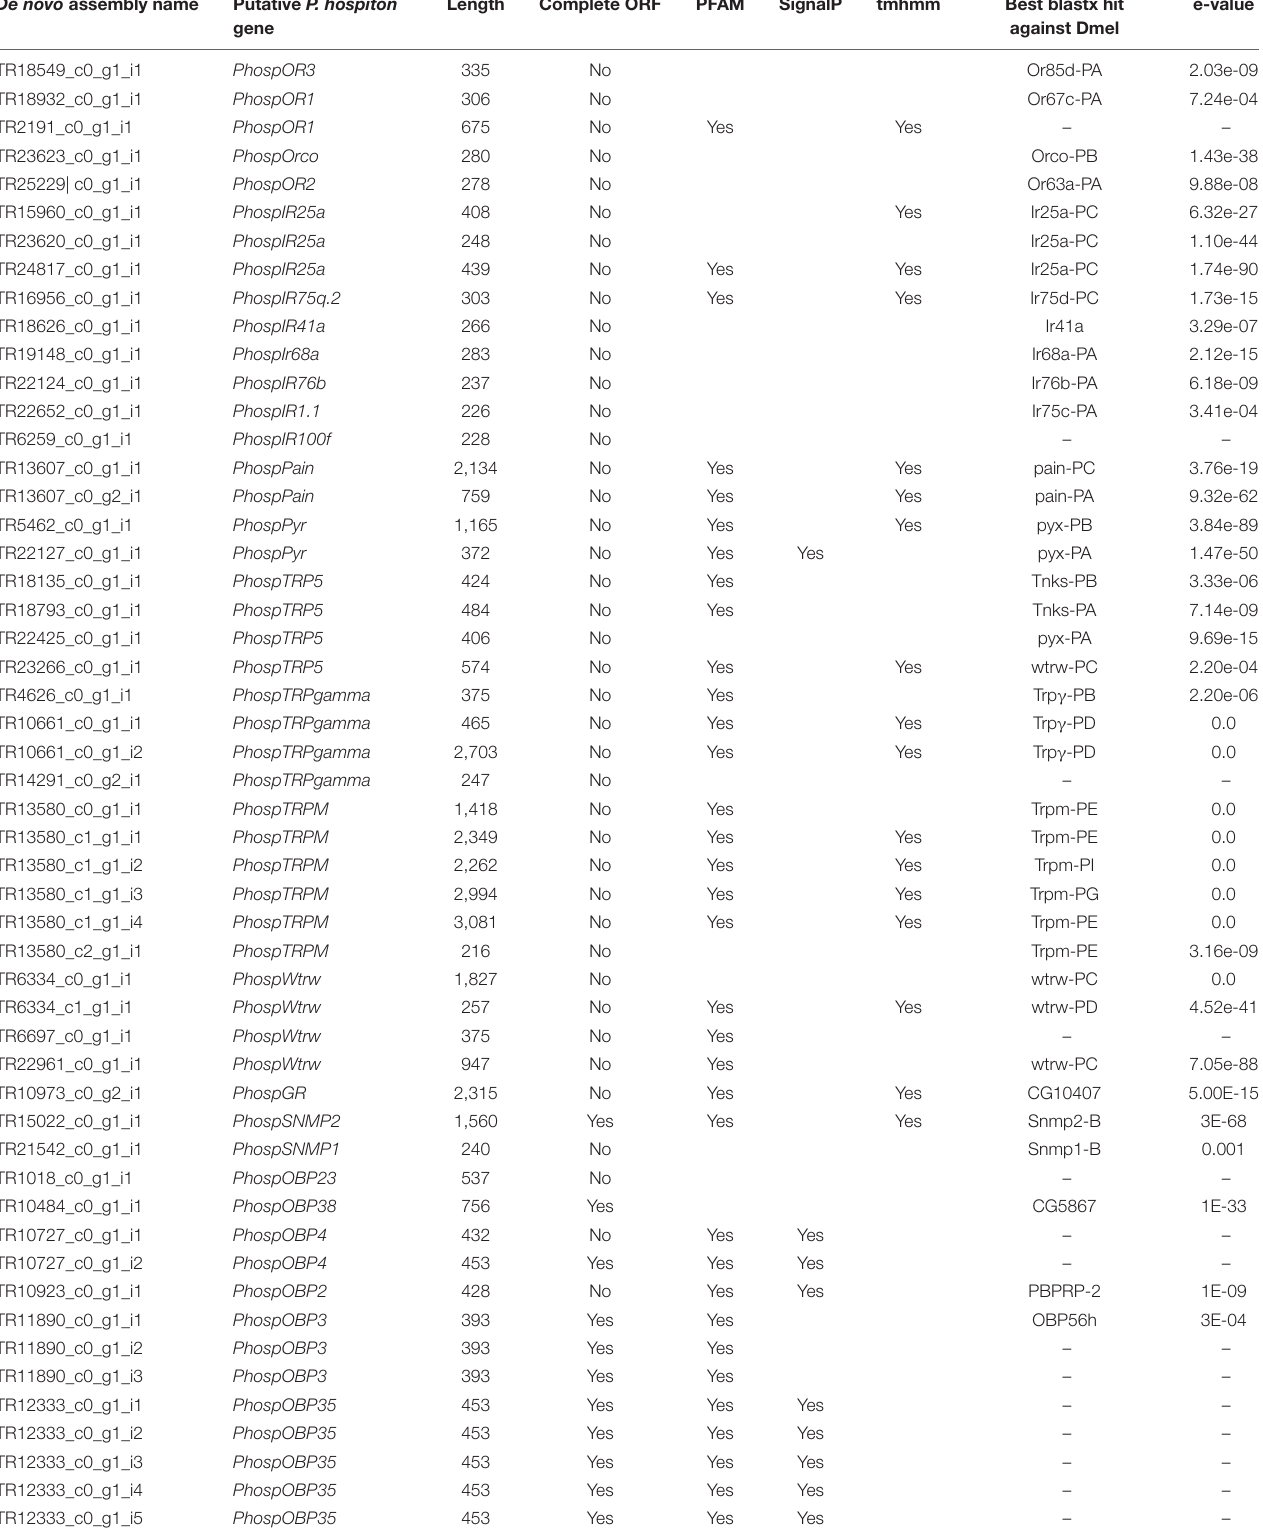
TABLE 1 | Contigs identified as putative transcripts related to chemical sensing and transcripts for TRP-channels. De novo assembly